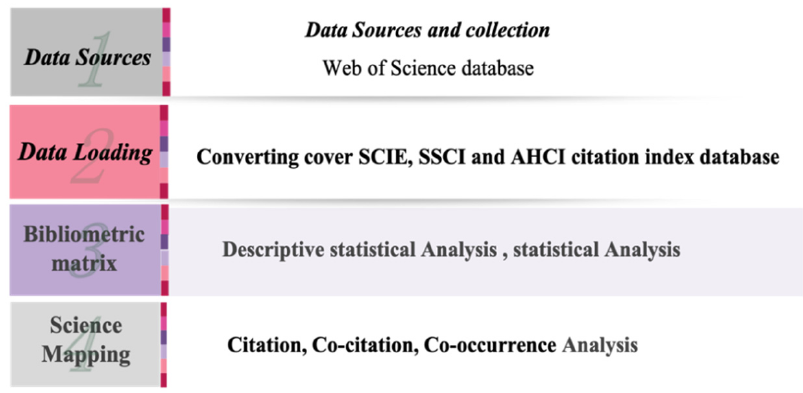
Figure 1. Visualization analysis and science-mapping workflow.